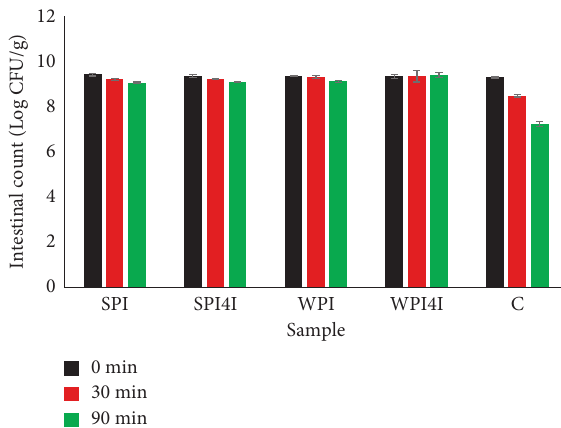
Figure 8: Viability of L. reuteri encapsulated within different wall materials in intestinal condition; SPI (soy protein isolate 20%), SPI4I (soy protein isolate 20% +inulin 4%), WPI (whey protein isolate 20%), WPI4I (whey protein isolate 20% +inulin 4%), and C (free